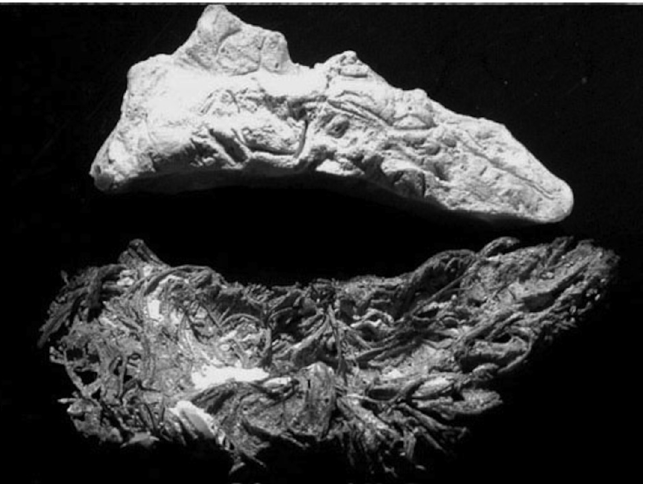
Fig 10. This is the cast of an anterior adult mandible or maxilla in the incisor region. No incisors are evident in this cast. Therefore, we interpret that this cast is from an individual who was at least partially edentulous. Edentulous conditions are normal after 30 years of age among populations who subsist on desert succulents (Anderson 1967; Marks et al 1988; Danielson and Reinhard